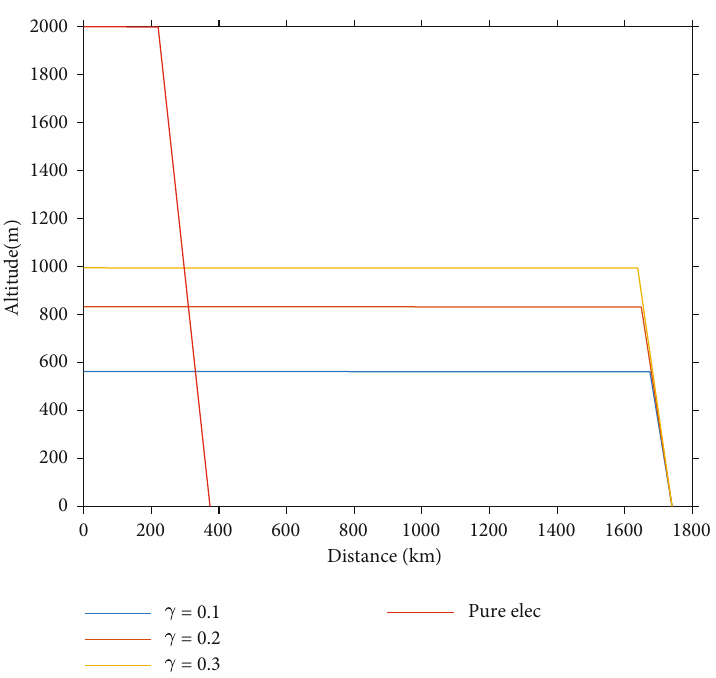
Figure 11: Di ff erent areas of mission pro fi le ( payload = 10